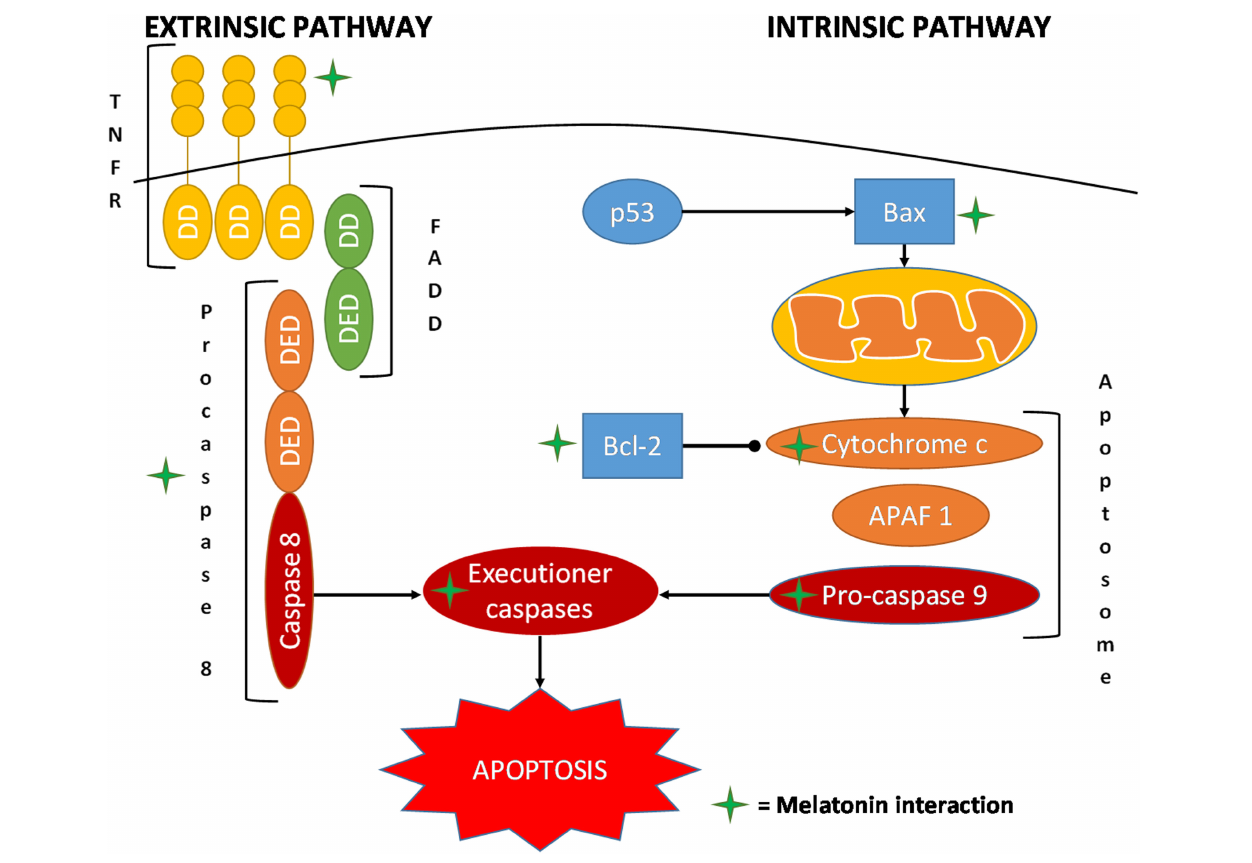
FIGURE 4 | Schematic representation of the main interaction of melatonin in the pathways of apoptosis. APAF 1, apoptotic protease-activating factor 1; DD, death domain; DED, death effector domain; FADD, Fas-associated protein with death domain; TNFRSF, tumor necrosis factor receptor superfamily.